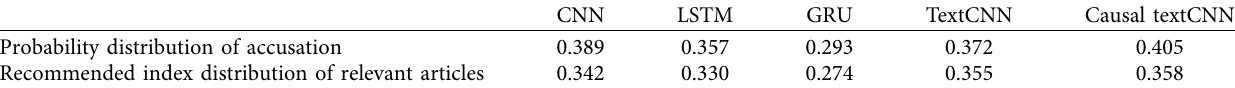
Table 5: Score of model before and after feature fusion.